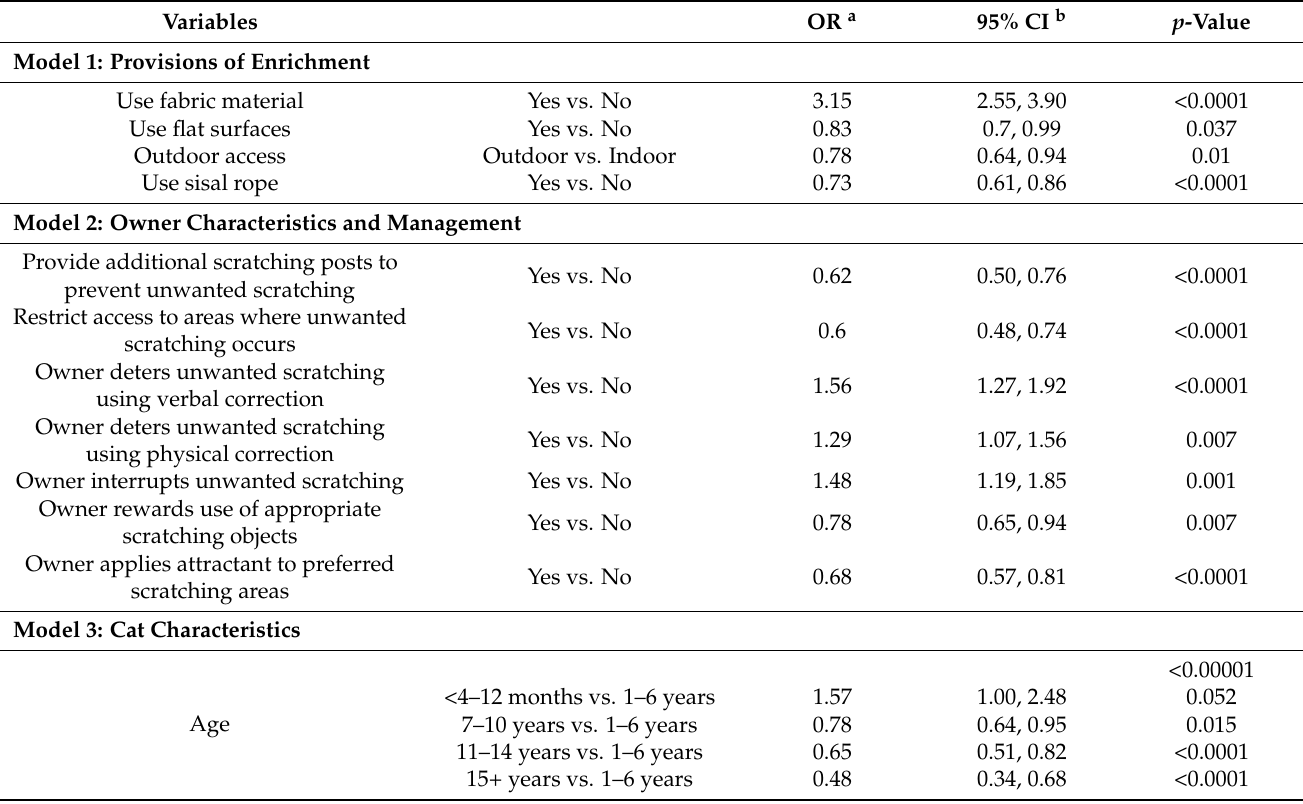
Table 3. Logistic regression models of cat characteristics ( n = 2446), owner demographic factors and management ( n = 2434), and provisions of enrichment ( n = 2218) associated with unwanted scratching